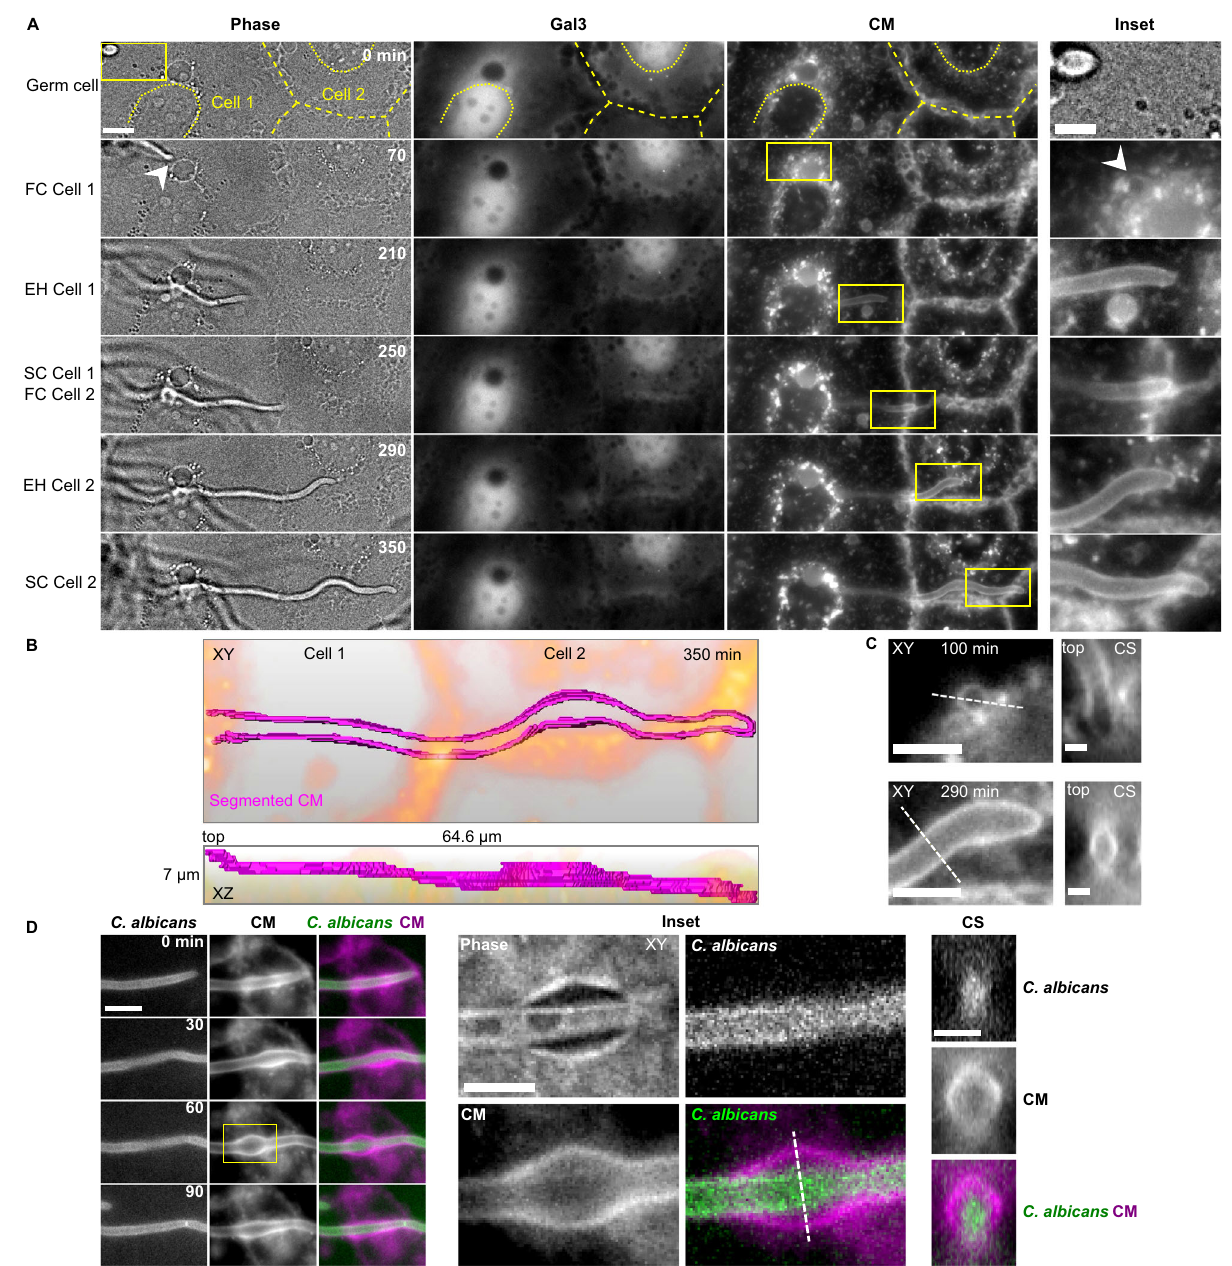
Fig. 3 Invasion into Caco-2 occurs via a single non-damaging scenario. A Caco-2 expressing Gal-3 are invaded by a single invasion scenario without Gal-3 recruitment or host cell death. A representative live-cell imaging acquisition of invasions through two successive cells (cell 1 and cell 2) is presented. The six time points correspond to the invasion stages de fi ned in Fig. 1. Phase (single z slice), Gal-3 and CM (maximum intensity projection of seven slices) channels, together with an inset (yellow frame) are presented for each time point. The outlines of the two invaded Caco-2 and their nuclei are highlighted with dashed and dotted yellow lines respectively. The entry point into the Caco-2 layer is marked by an arrowhead. B Three-dimensional representation of CM labelling (magenta) presented in ( A ) within the entire acquisition volume at a single time point (350min). Epithelial cell outlines are in orange. A top view (XY) and side view (XZ) are presented together with the volume dimensions. C CM channel insets of two time points from the data presented in (A) are presented together with cross-section (CS) views derived from the dashed lines. D Live-cell imaging of infection of Caco-2 not expressing Gal-3 with a C. albicans strain expressing GFP γ . An average intensity projection of fi ve slices is presented. A local transient ‘ in fl ation ’ is observed in the CM channel. An inset (yellow frame) showing a clear separation between the CM labelling and C. albicans when the ‘ in fl ation ’ is at its maximum size is presented in XY and in a cross section (CS) derived from the dotted line. As the hypha presented has extended from a previously invaded host cell, it is already entirely surrounded by CM labelling at time 0min. Scale bars are 10 µ m in ( A , D ), 5 µ m in ( A ) Inset, ( C ) XY views and ( D ) inset, and 2 µ m in ( C ) CS fl exneri invasion, this ‘ exclusion layer ’ likely represents a region of (see Fig. 4Bc). Invasion into the second host cell in the sequence (cell 2) started with the enveloping of the structures surrounding actin enrichment 14,46 . The ‘ exclusion layer ’ became progressively thinner as the fi lament extended through cell 1, and was even- the fi lament in cell 1 by the plasma membrane of cell 2 (see tually enveloped by the plasma membrane upon exit from cell 1 Fig. 4Bd), forming a thicker, clearly visible membrane structure